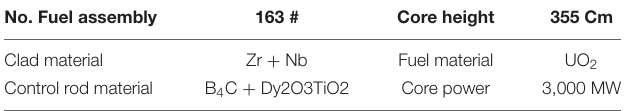
TABLE 2 | Input specification for MCNPX 2.7 code.